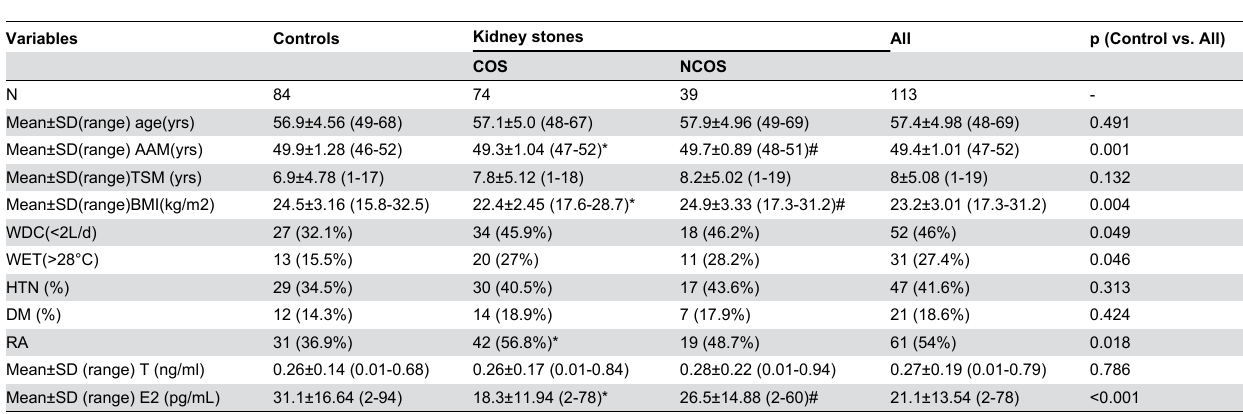
Table 1. Demographic, clinical, and biochemical